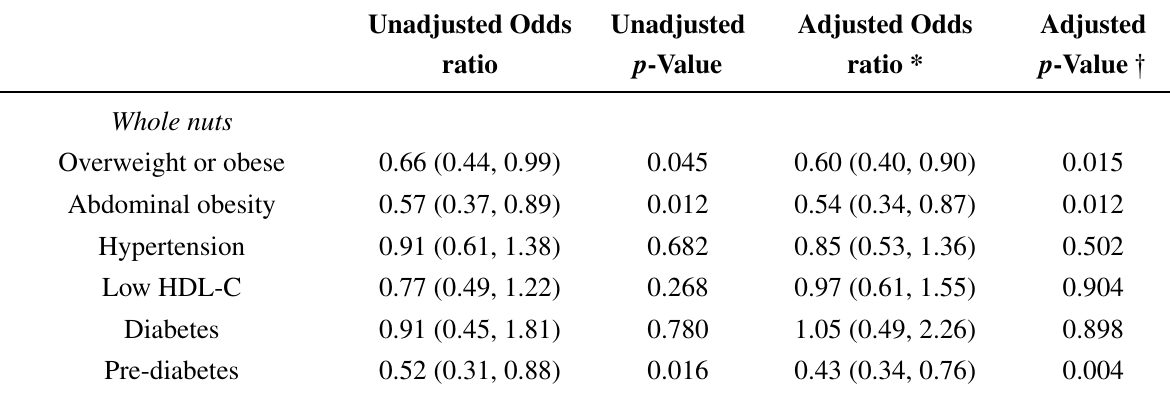
Odds ratio (95% CI) for diabetes and risk factors for chronic disease by nut